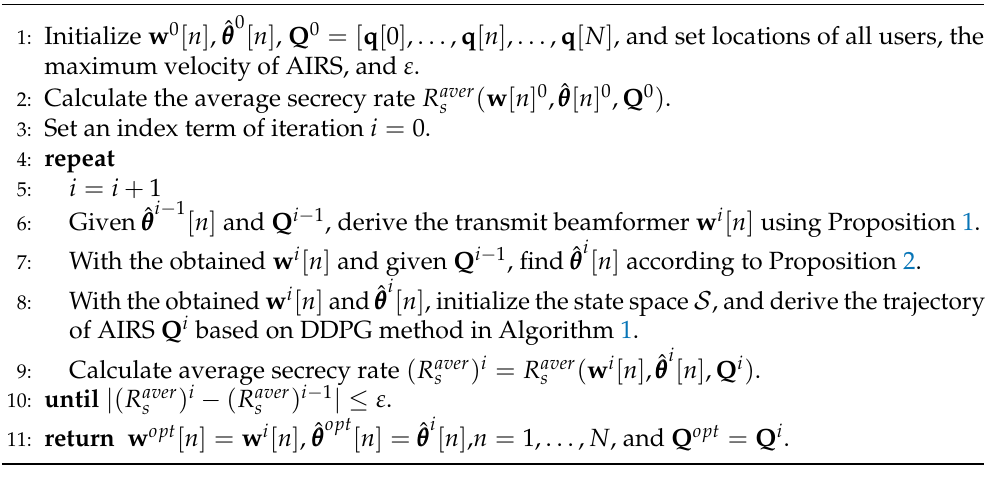
Algorithm 2 Algorithm for Average Secrecy Rate